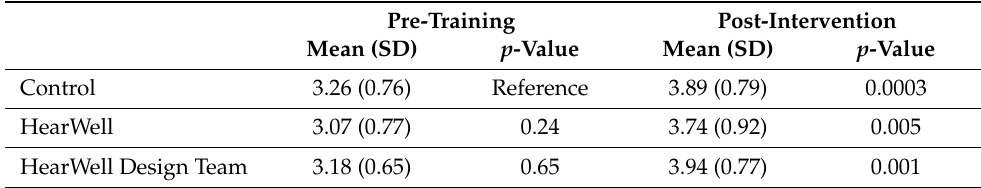
Table 5. Hearing climate by intervention arm pre-training and post-intervention. p -values represent the statistical significance as compared to the control at pre-training using a mixed linear model.